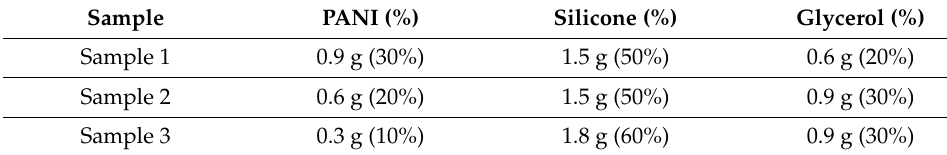
Table 1. Comparison between different prepared electrode mass